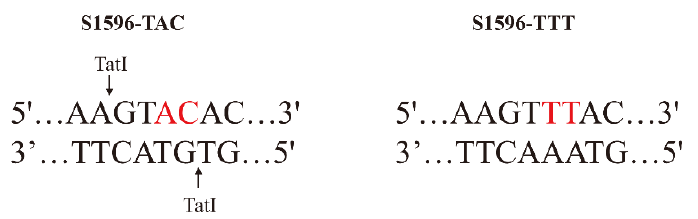
Figure 4. Analysis of restriction enzyme digesting sites of S1596.